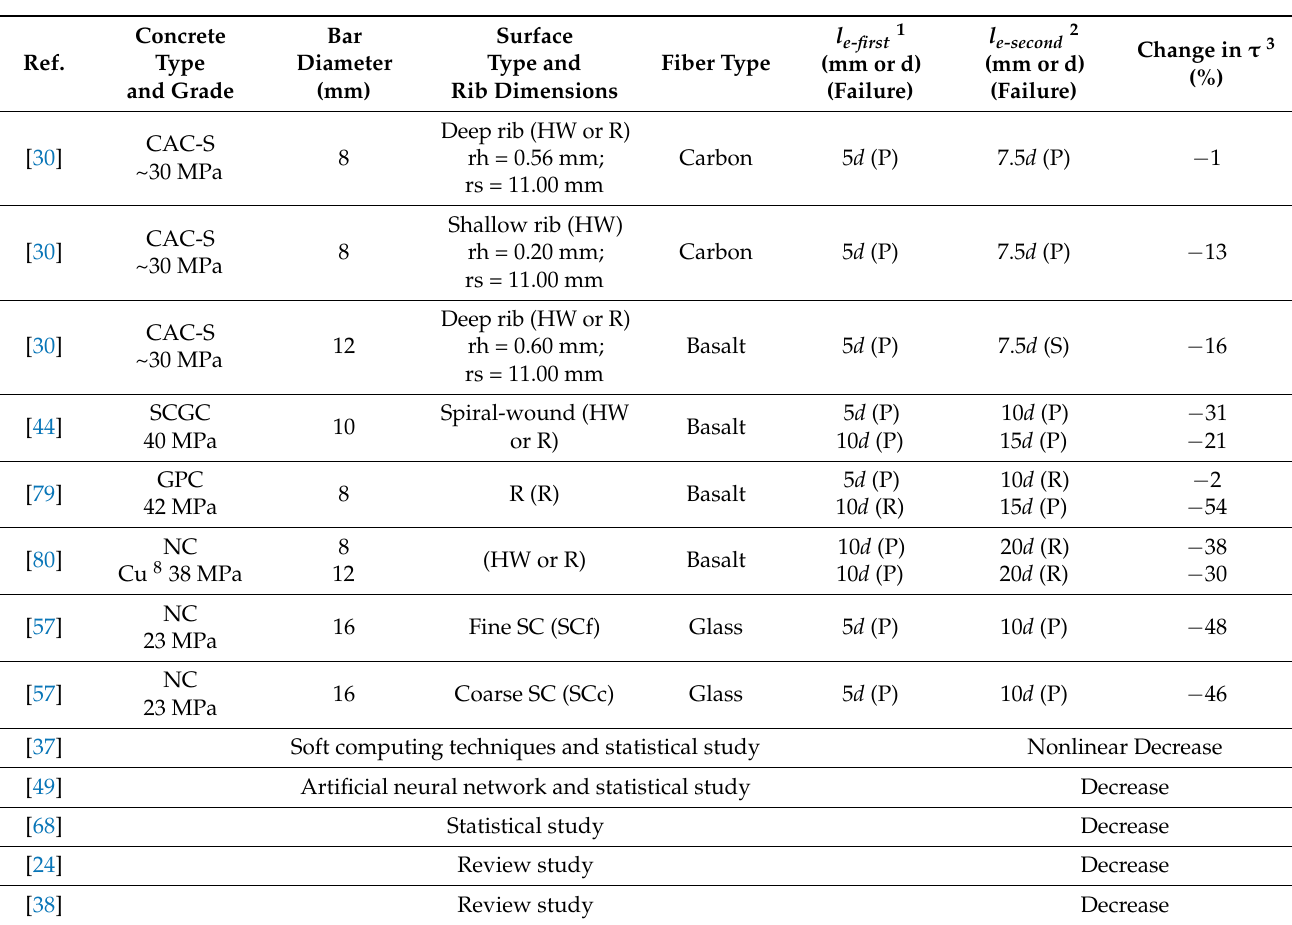
Figure 6. Bond failure types ( a ) pure pullout; ( b ) conventional concrete cover; ( c ) V-shaped concrete cover; ( d ) diagonal concrete cover; ( e ) concrete block split [71].